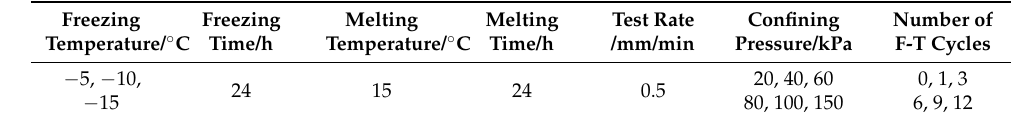
Table 2. Parameters for triaxial test.